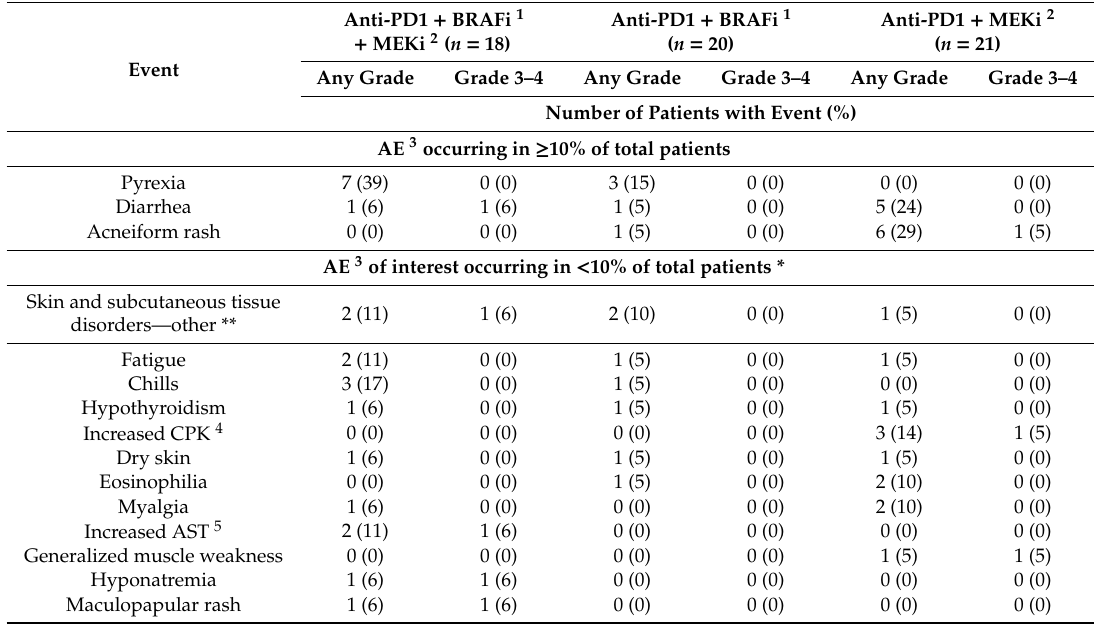
Table 3. Main treatment-related adverse events.